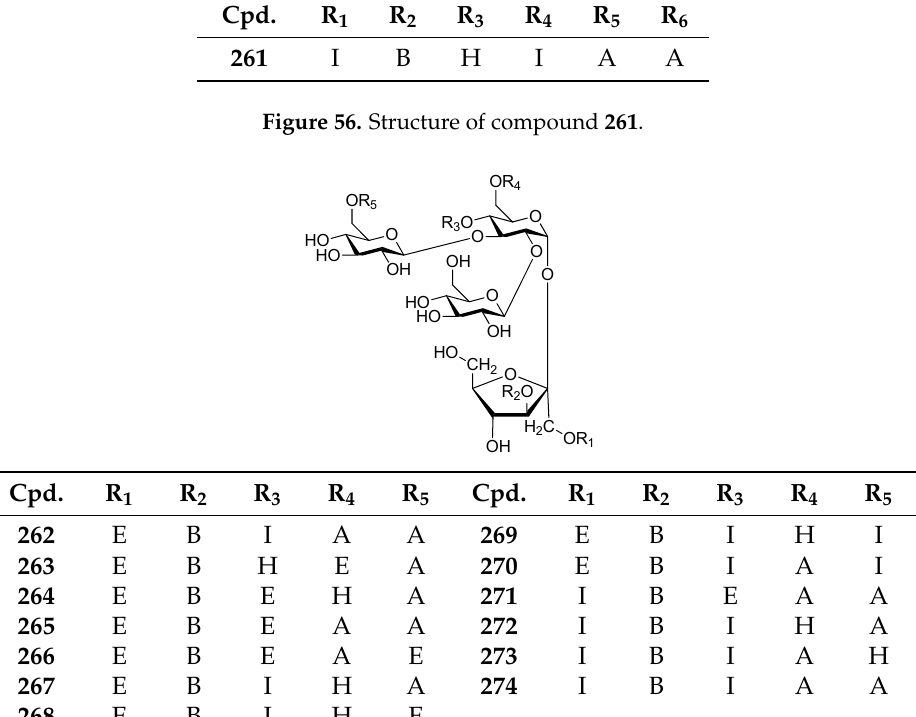
Figure 57. Structures of compounds 262 – 274 .